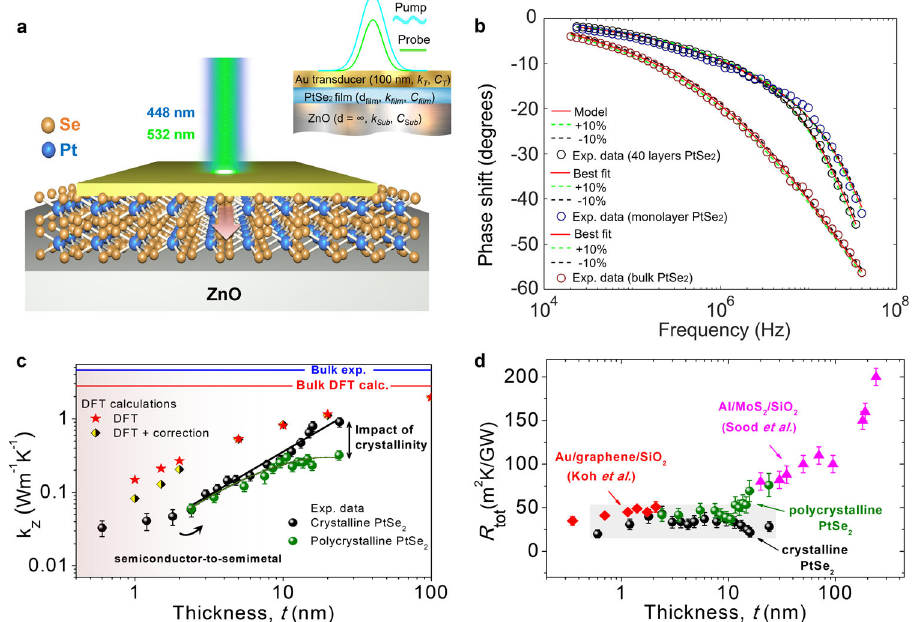
Fig. 3 Thermal conductivity and interfacial heat transport measurements. a Schematic illustrations of the FDTR technique and the multilayer system. b Typical FDTR data measured in bulk PtSe 2 (red circles), 40 layers (black circles), and monolayer (blue circles) crystalline PtSe 2 fi lms and the corresponding best model fi ts in the whole frequency range. c Cross-plane thermal conductivity k z of crystalline (black spheres) and polycrystalline (green spheres) PtSe 2 fi lms versus fi lm thickness t . The uncertainty of the estimated k z was calculated based on error propagation for the input parameters. The blue and red lines in ( a ) display the bulk cross-plane thermal conductivity values obtained by FDTR and DFT calculations, respectively. The black and green curves are a guide for the eye. d Total thermal resistance, R total = R int + R PtSe2 , of crystalline (black spheres) and polycrystalline (green spheres) PtSe 2 thin fi lms, plotted versus fi lm thickness t . The uncertainty region is displayed as a gray rectangle. The total cross-plane thermal resistance measurements of Au/graphene/SiO 247 (red diamonds) and Al/MoS 2 / SiO 241 (purple triangles) interfaces are also